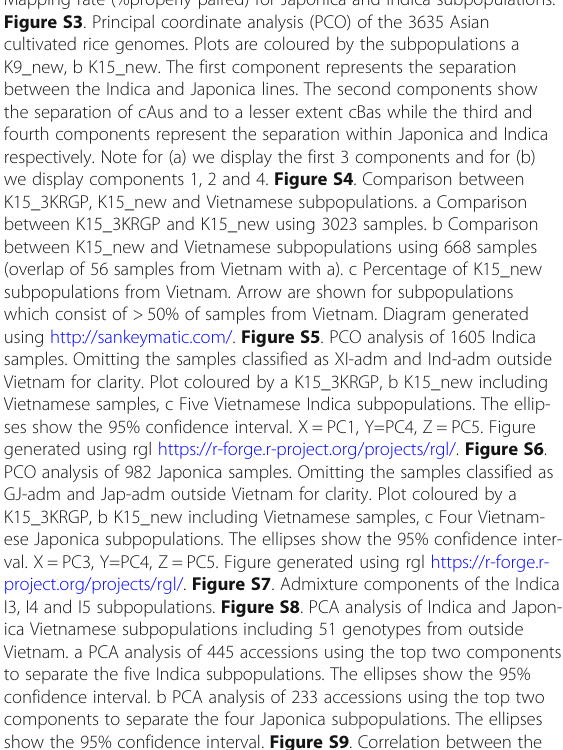
Detailing the new subpopulation and PCO analysis. Table S3 . Phenotypic measurements for 20 traits for 672 samples. Detailing individual measurements for each sample, description of phenotypes, statistics for all samples and individually for the Indica and Japonica subtypes. Phenotypes are available for around 75% of the samples. Table S4 . Phenotype abbreviations and details. Table S5 . Phenotype statistics (mean and coefficient of variation) and population comparisons (t-test). Table S6 . Diversity ( π ) of each subpopulation. Table S7 . GWAS results. List of the 21 QTL and the positions of the individual QTLs for each panel. Table S8 . Gene lists for the 21 QTL. Table S9 List of 107 IRRI rice samples. Detailing IRRI accession, country on origin, K9 and K15 group and Vietnamese subpopulation. Table S10 . List of 14 SNP sets used for analysis. Detailing filtering parameters, sample and SNP numbers for each SNP set. Table S11 . Summary count of SNPs with effects on the